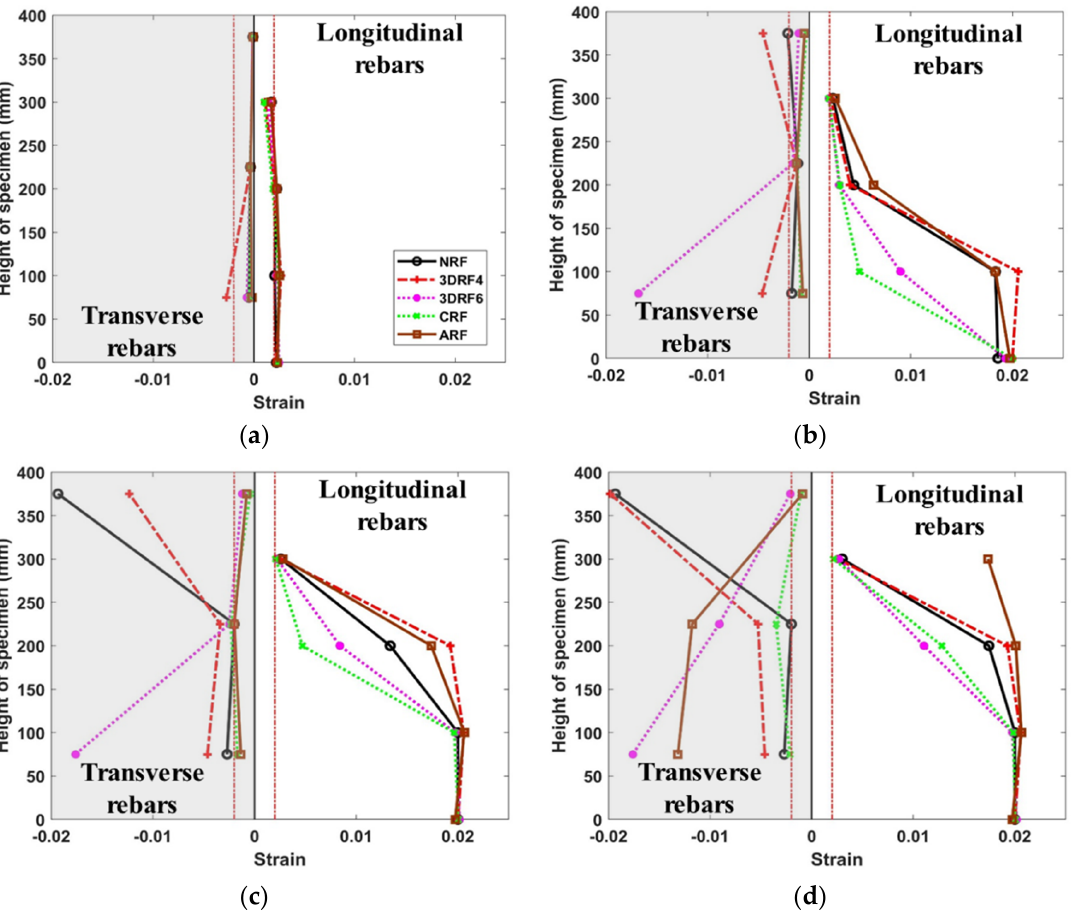
Figure 14. The effect on strain distribution: ( a ) Drift ratio of 1%; ( b ) Drift ratio of 2%; ( c ) Drift ratio of 4%; ( d ) Drift ratio of 6%.